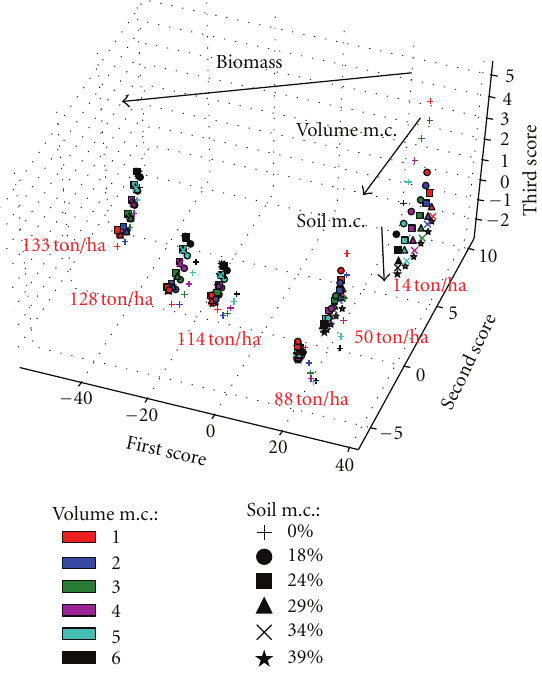
with radar HH, HV, VV radiometry and optical NDVI, GVMI and NINSOL